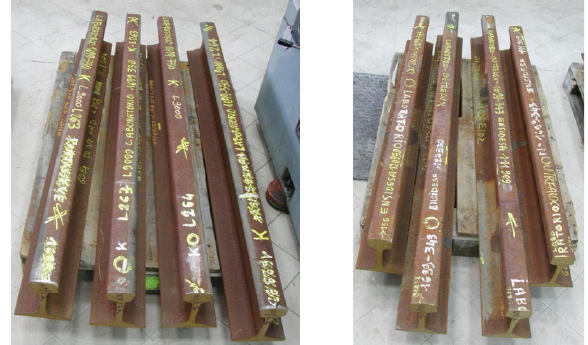
Figure 1: Rail sections from which specimens have been extracted.